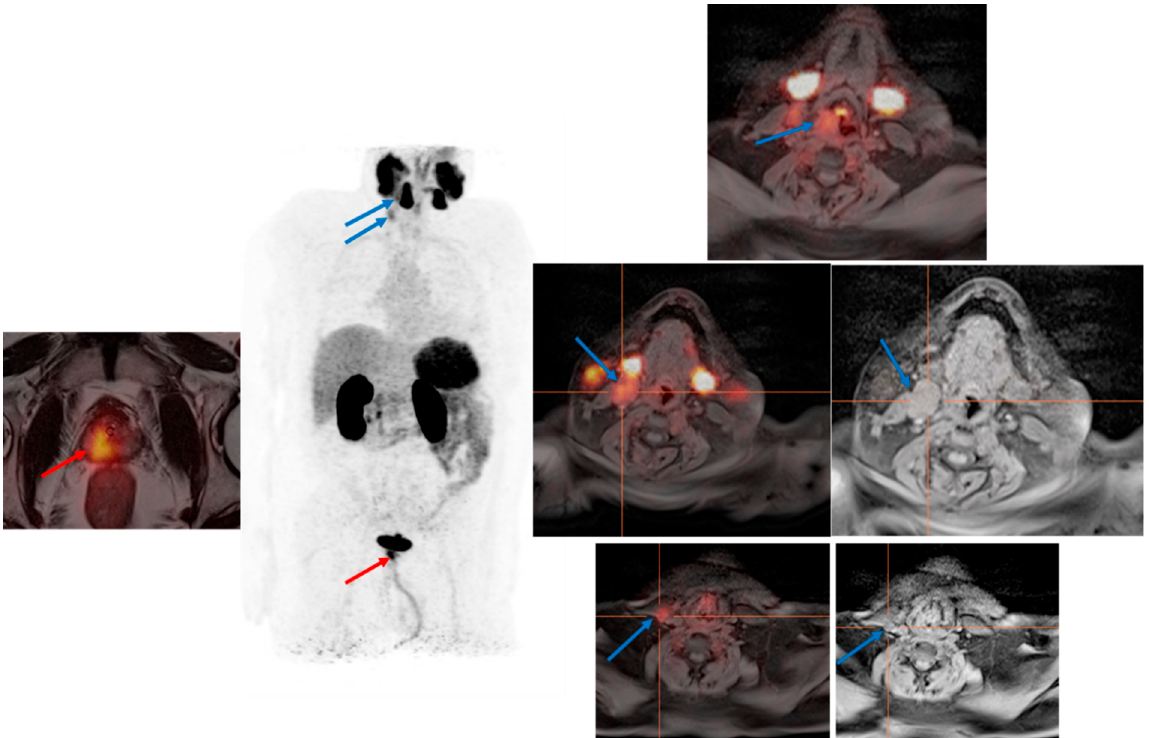
Figure 4. PSMA PET examination for primary staging of a high-risk prostate cancer. PSMA PET examination for primary staging of a 60 year old patient with a newly diagnosed high-risk prostate cancer (PSA value: 30.9 ng/mL) revealed the primary tumor in the right lobe of the prostate with a clear PSMA-expression (red arrow) and an incidental detection of a suspicious lesion with marked PSMA expression in the right piriform sinus (area of the right vocal cord) with multiple suspicious lymph nodes in the right neck region (blue arrows). The final histological examination of this neck lesion confirmed squamous cell carcinoma of the larynx.